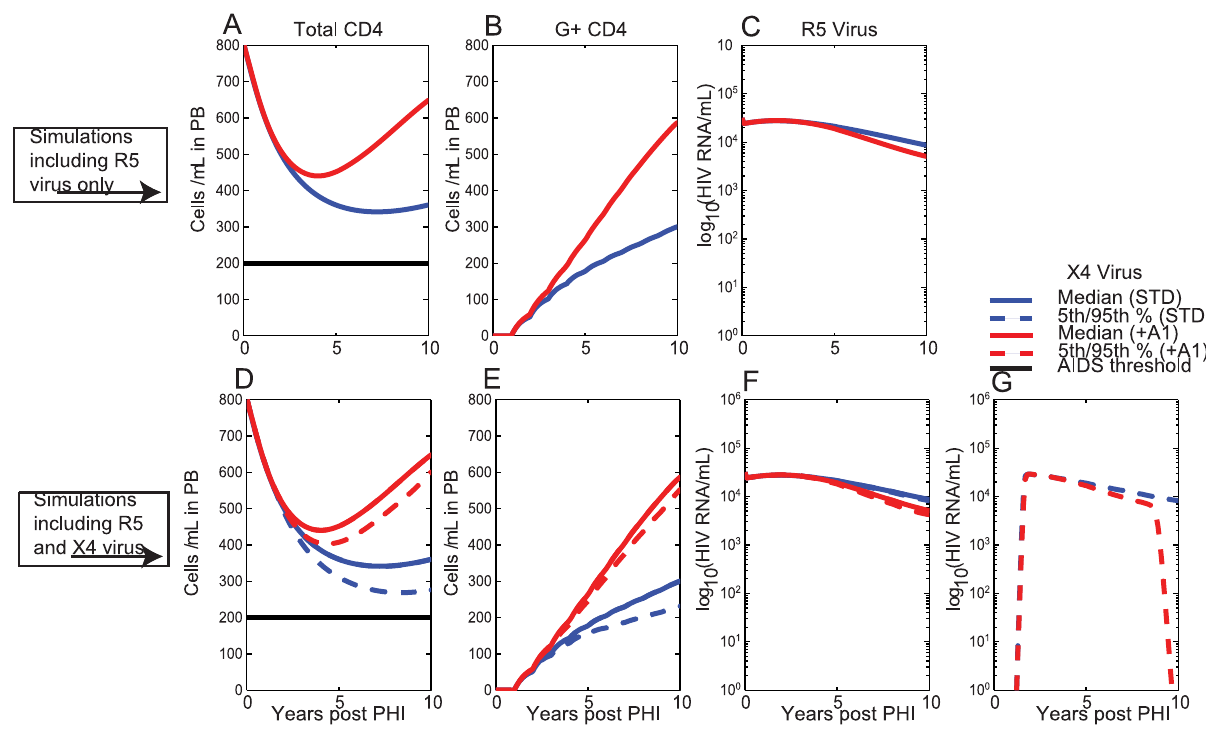
Figure 6. Repeated annual delivery of gene therapy to CD34 + HSC assuming that 20% of CD34 + HSC in the bone marrow receive the gene construct every year from year 1 (i.e. every year, starting from year 1, 20% of G- CD34 + HSC become G + CD34 + HSC). The legend for this figure is the same as for Figure 5.